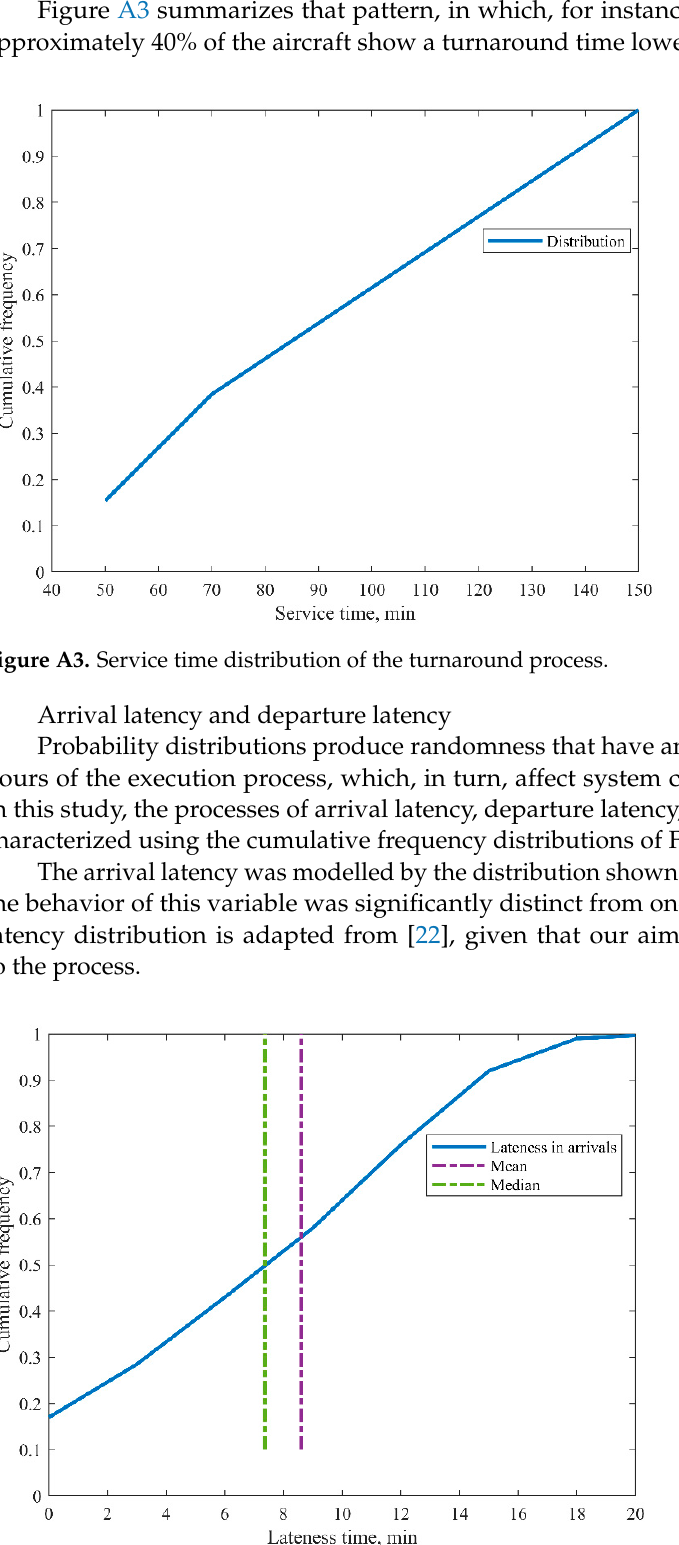
Figure A2. Taxiway conflicts.